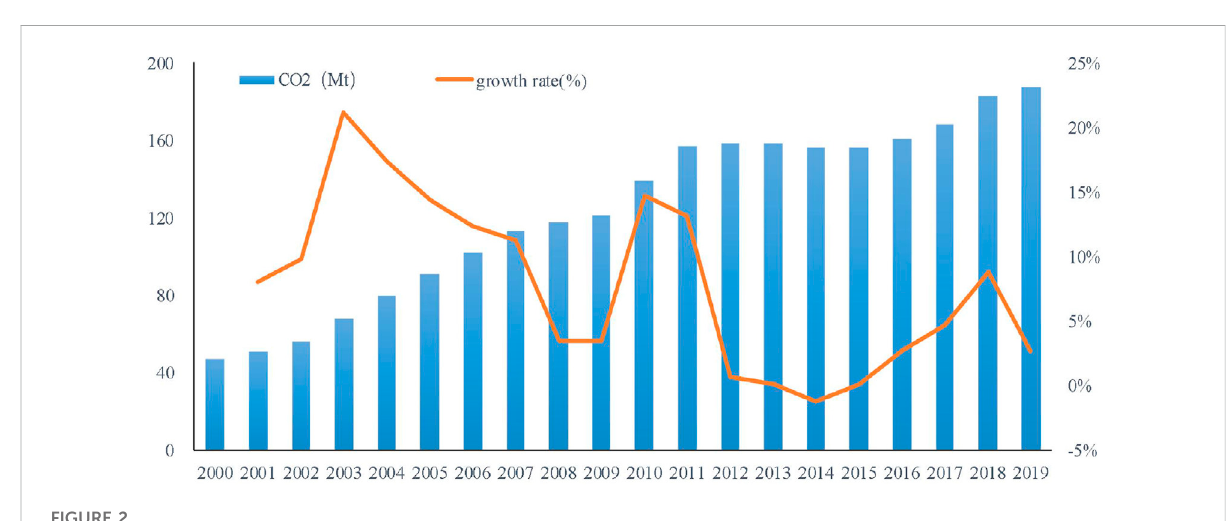
FIGURE 2 Carbon emissions of China ’ s provinces from 2000 to